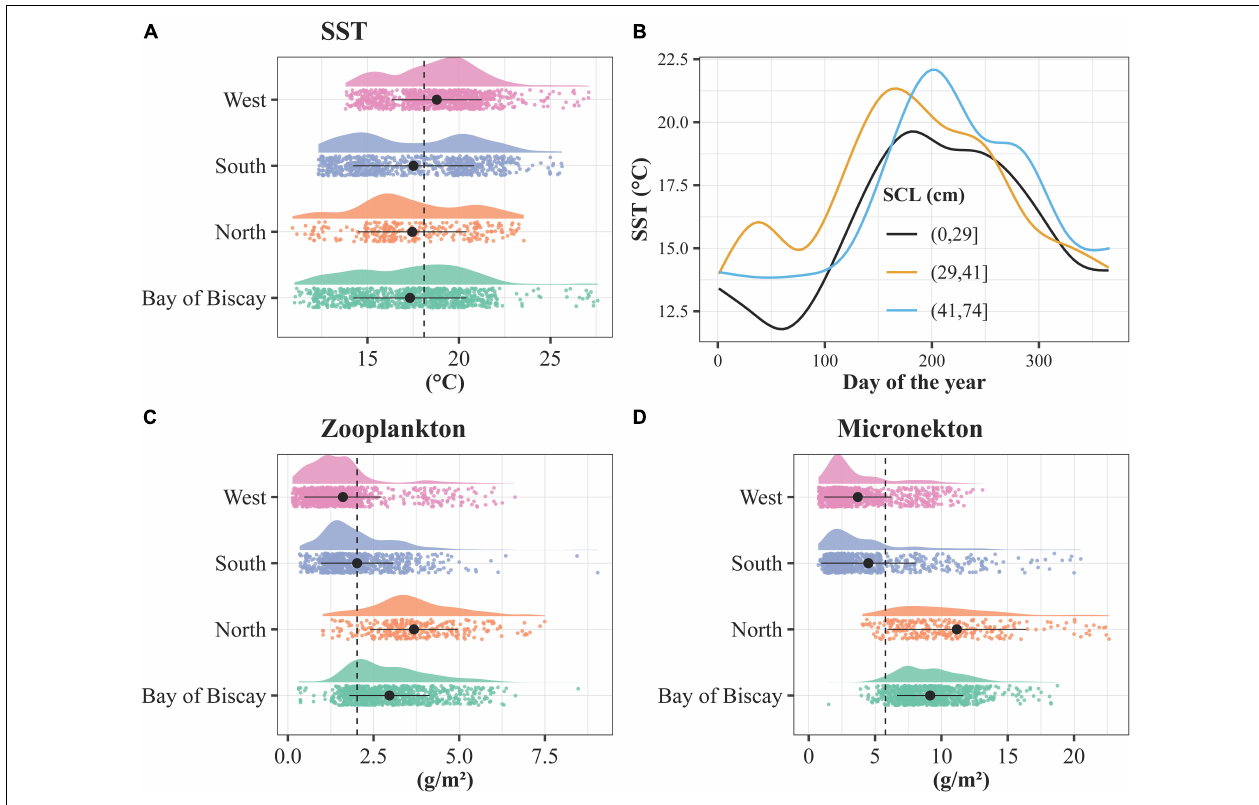
FIGURE 8 | (A) Smooth lines of the SST at turtle’s locations according to days of the year and SCLmin classes (in cm). Density distributions of the (B) SST, (C) zooplankton biomass and (D) micronekton biomass extracted at the turtle’s locations according to the spatial pattern. The density distributions are color-coded by spatial pattern, with a cloud of points below. The dotted lines refer to the average zooplankton and micronekton biomasses considering the 26 tracked individuals. The black dots stand for the mean and the bars the standard deviation for each